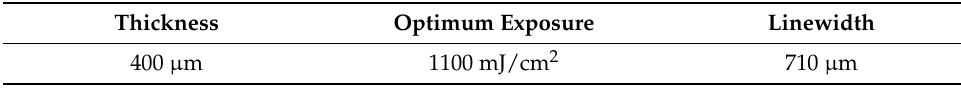
Table 2. Optimum exposure for the SU-8 layer.